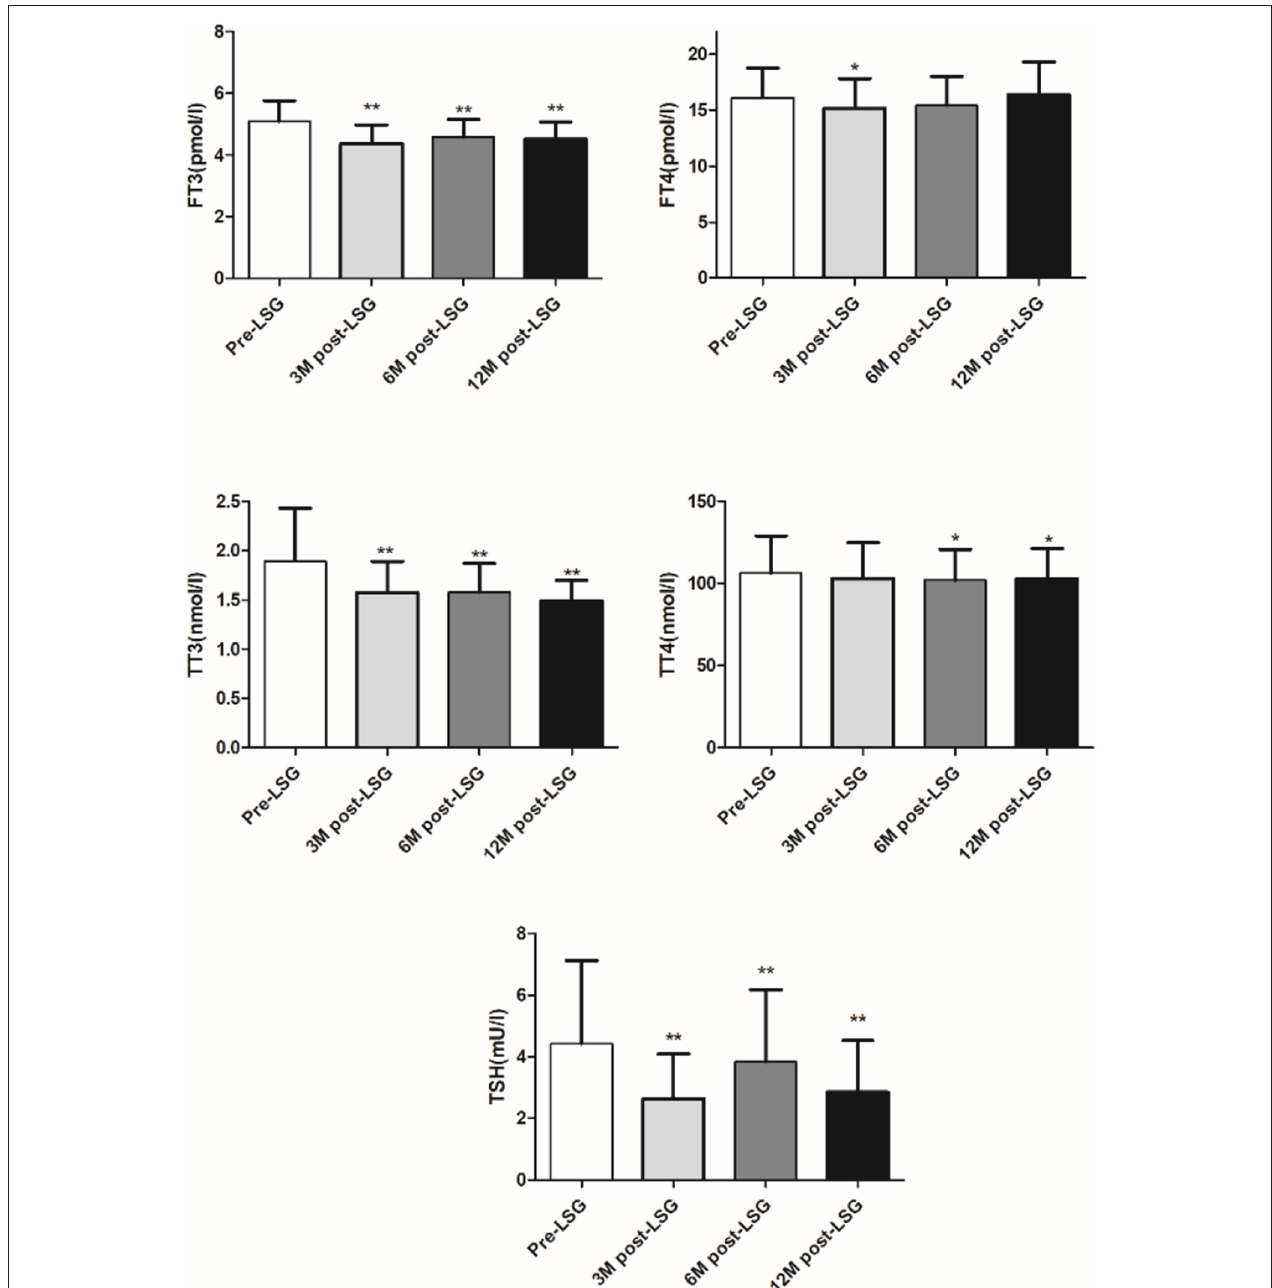
FIGURE 4 | Change in thyroid hormone after LSG. * P < 0.05,** P <